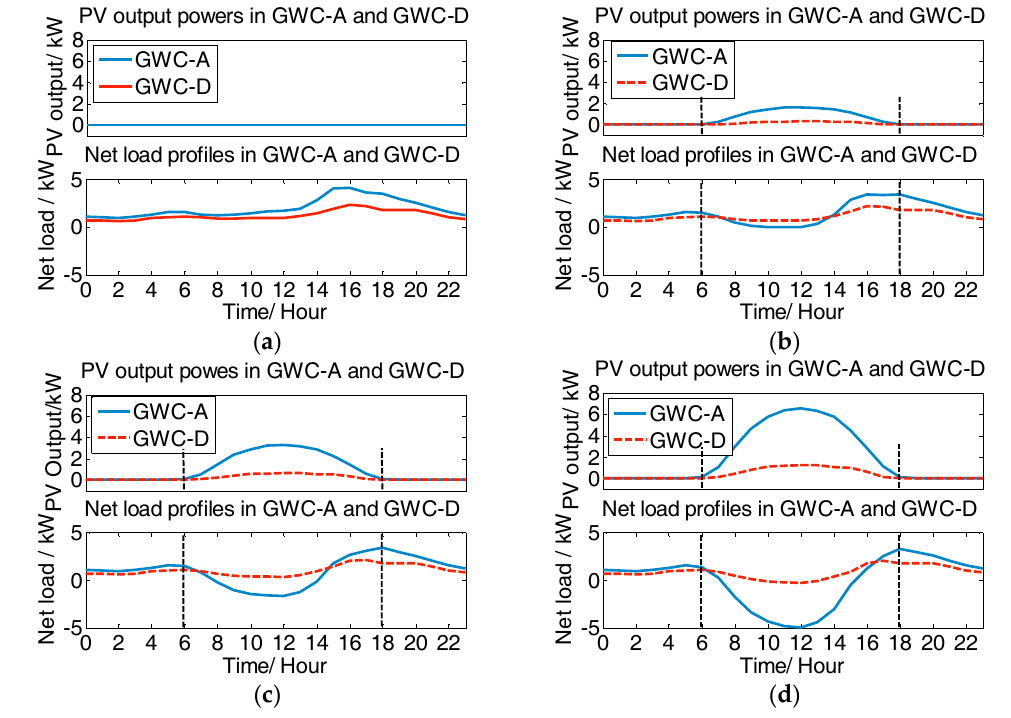
Figure 3. PV output power and net load curves of customers with different DPVS capacities in different GWCs. ( a ) PV capacity = 0 kWp; ( b ) PV capacity = 2.5 kWp; ( c ) PV capacity = 5 kWp; ( d ) PV capacity = 10 kWp.